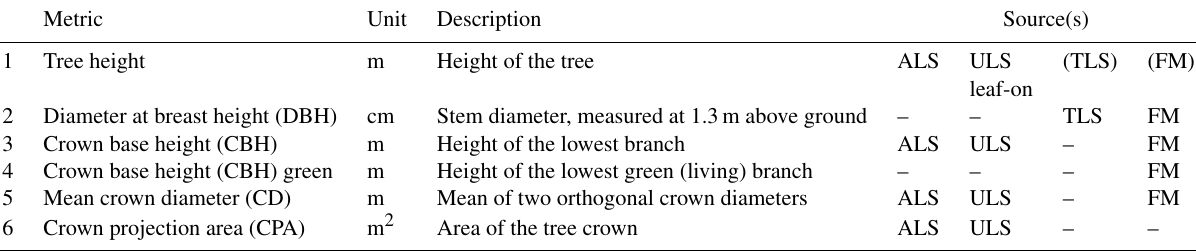
Table 3. Tree measurements and the source(s) they were recorded or computed from. Tree height was only measured from TLS point clouds for understory trees, for which tree height measurements from ALS or ULS would not be reliable. Tree height was only recorded in FM for smaller trees, where the top of the crown was visible from the ground (Sect. 2.4.1). ALS is airborne laser scanning, ULS is UAV-borne laser scanning, TLS is terrestrial laser scanning and FM is field measurements. All height measurements refer to height above the ground level at the stem position. For each tree, there can be multiple values for one tree metric if they were derived from different